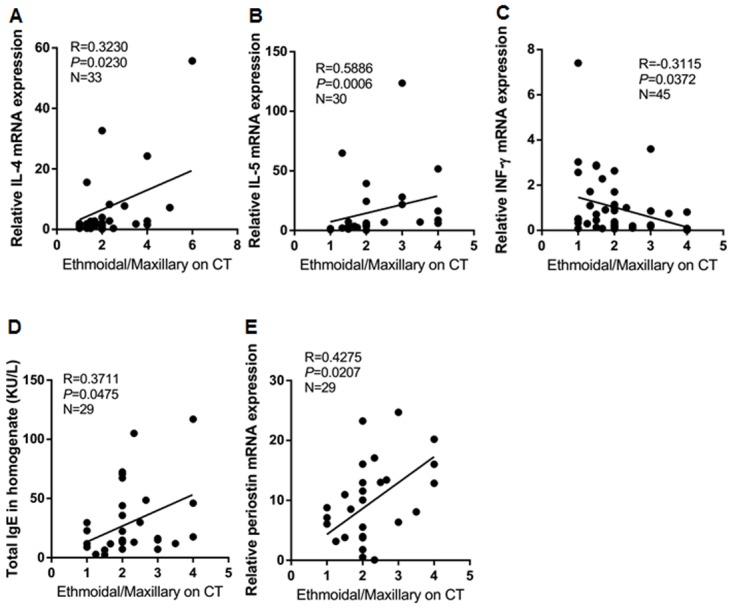
Correlation of the ratio of ethmoidal to maxillary CT scores with inflammatory markers in different endotypes of CRSwNP, including (A) IL–4 mRNA, (B) IL–5 mRNA, (C) IFN-γ mRNA, (D) total IgE homogenate, and (E) periostin mRNA.